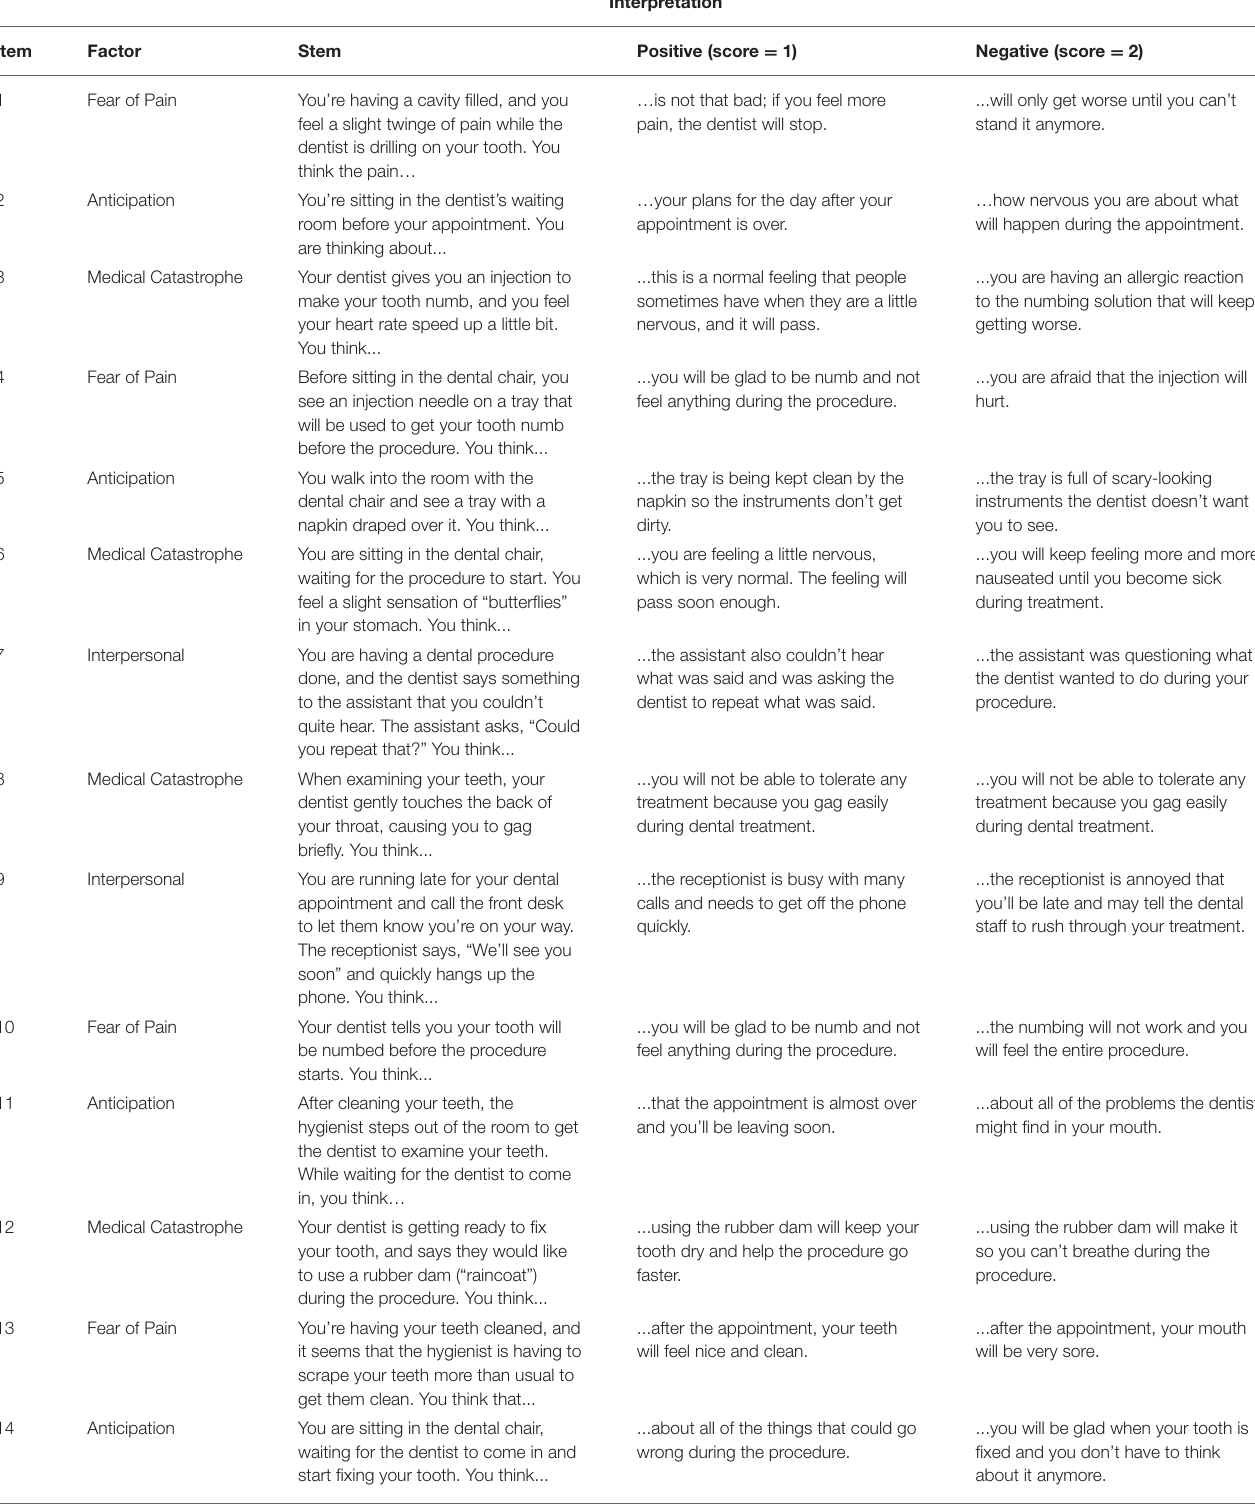
TABLE 4 | The Measure of Dental Anxiety Interpretational Bias (MoDAIB).